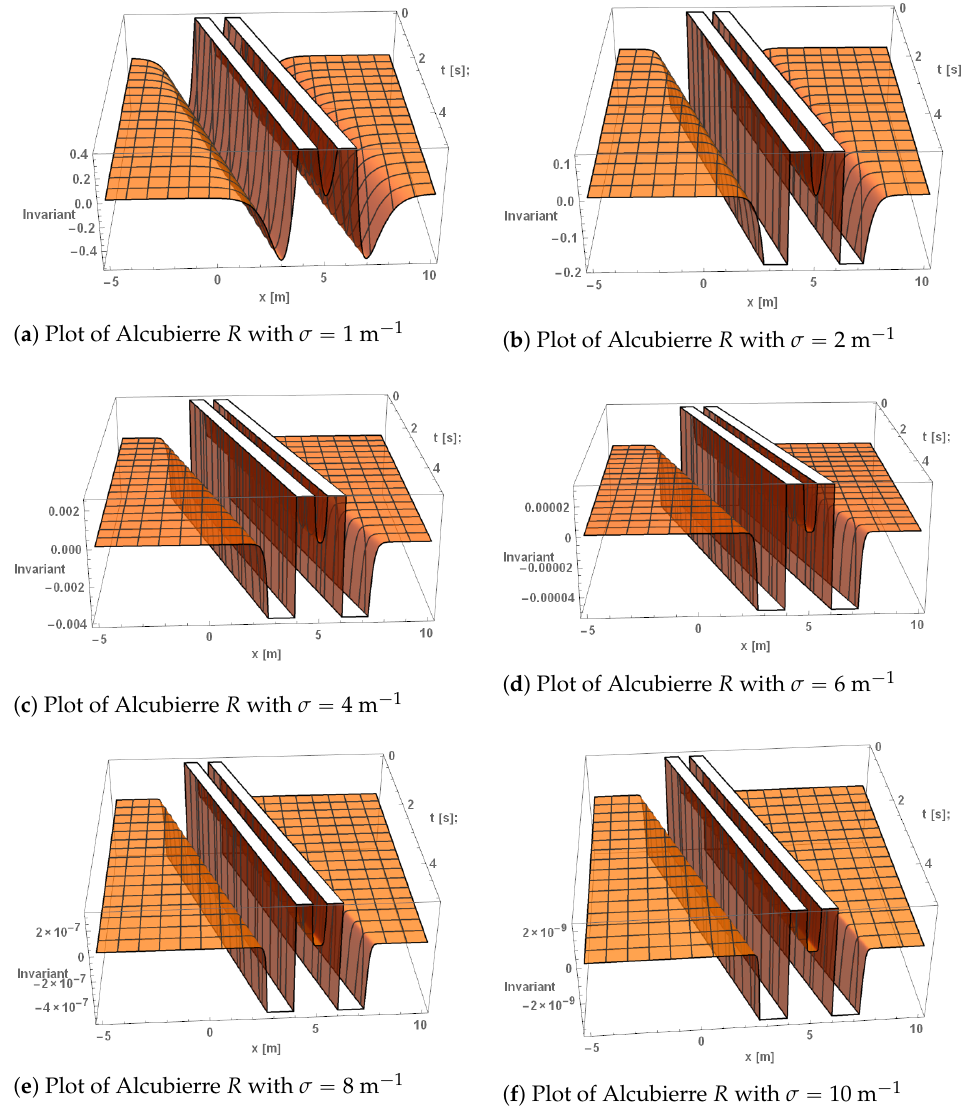
Figure 2. Plots of the R invariant for the Alcubierre warp drive while varying skin depth. The parameters were chosen as v s “ 1 c and ρ “ 1 m to match the parameters Alcubierre originally suggested in his paper